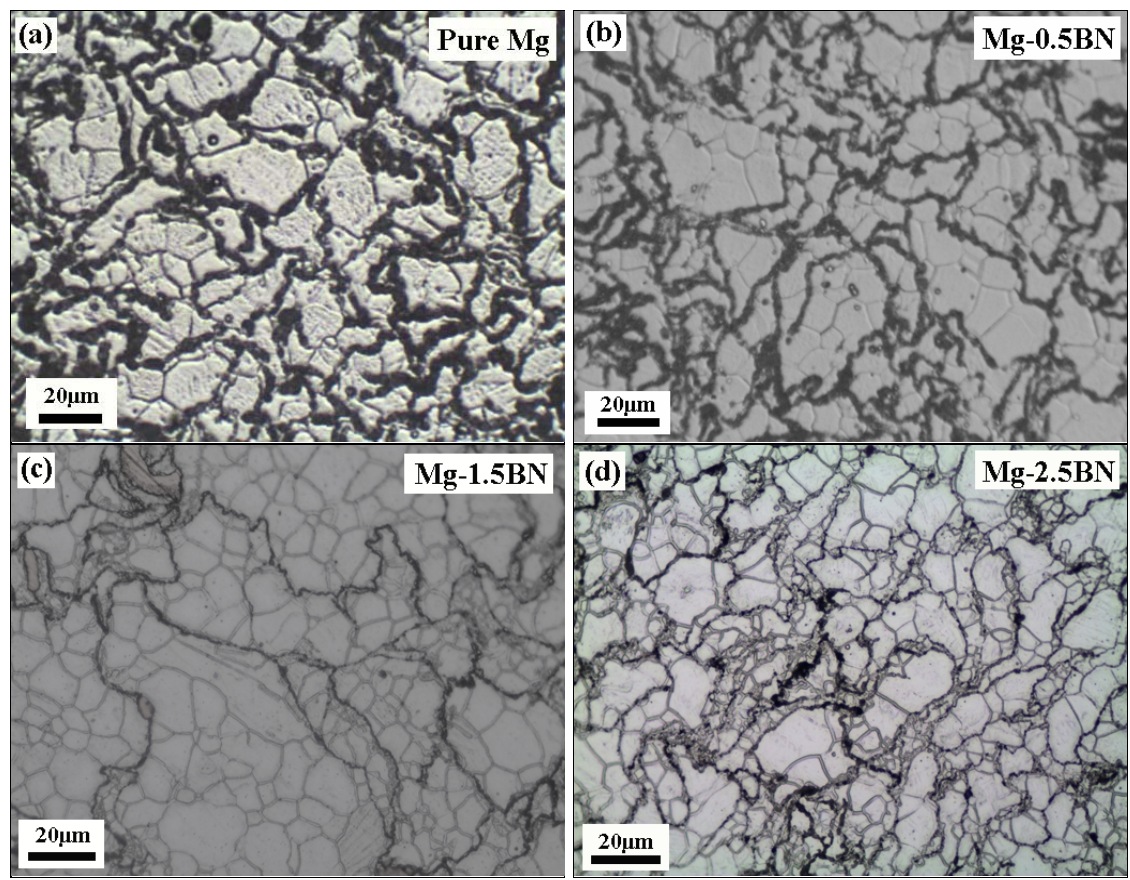
Figure 1. Optical micrographs showing the grain characteristics of: ( a ) pure Mg; ( b ) Mg-0.5BN; ( c ) Mg-1.5BN; and ( d ) Mg-2.5BN.